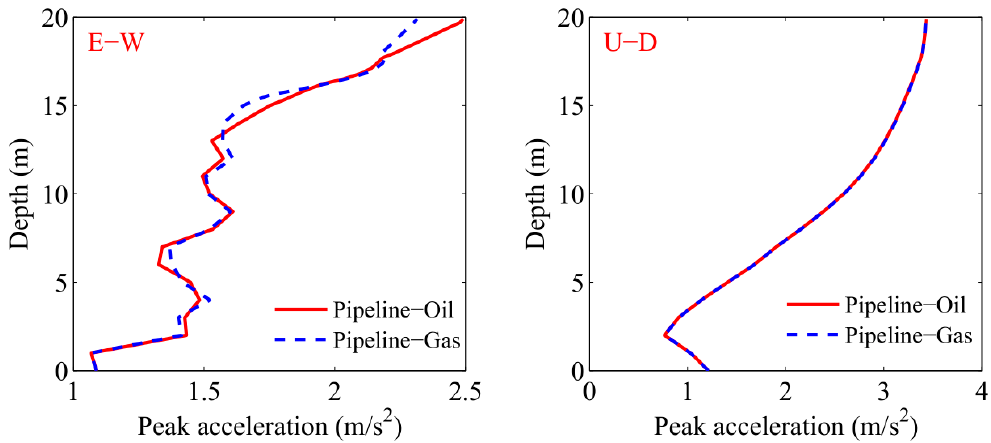
Figure 13. Amplification e ff ect of the seabed soil along depth. It is confirmed that the seabed foundation has significant amplification e ff ect to the input seismic wave in both horizontal and vertical